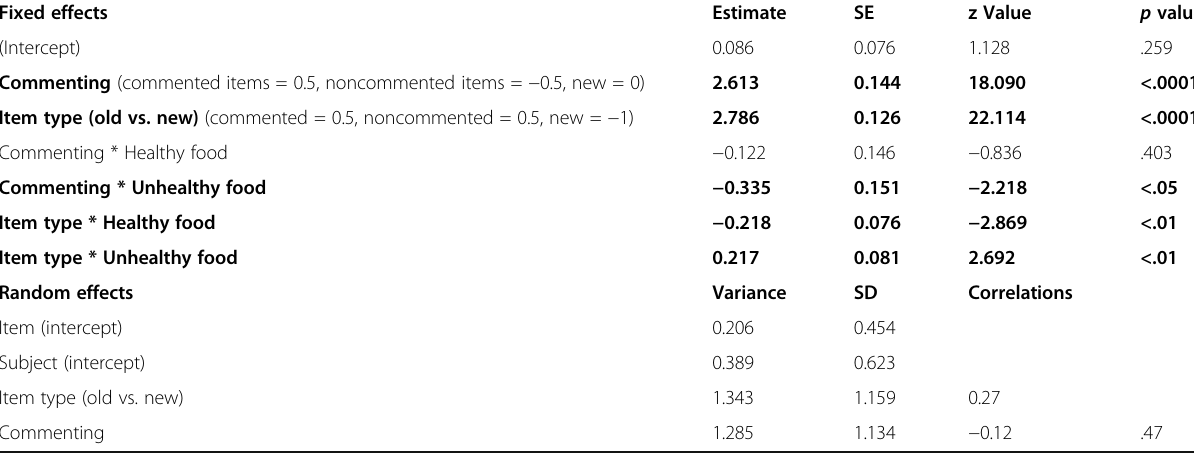
Table 1 Experiment 1: Memory by condition, model with random slopes